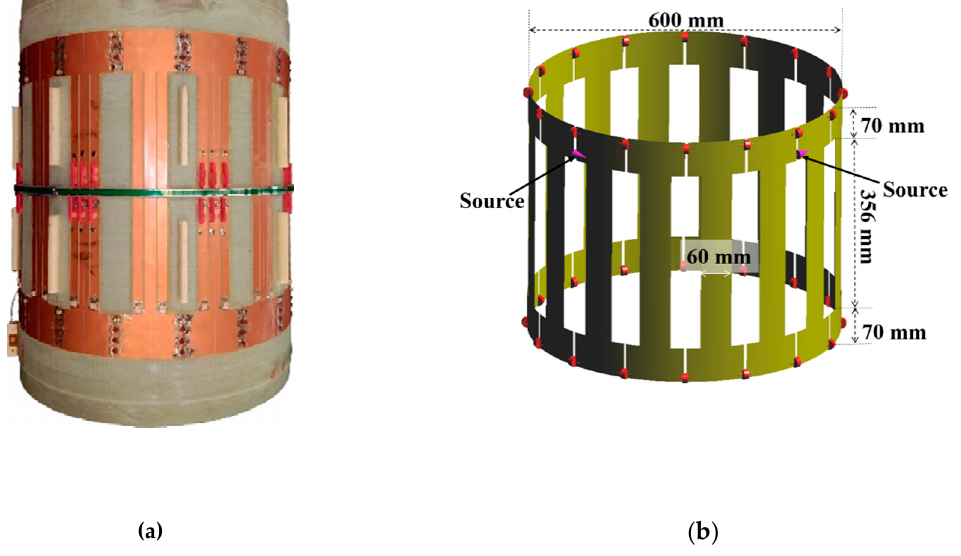
Figure 2. Structure of the MRI Tx coil: ( a ) Tx coil used in the experiment; ( b ) CAD model of the coil, the red dot indicates the positions of the capacitors.